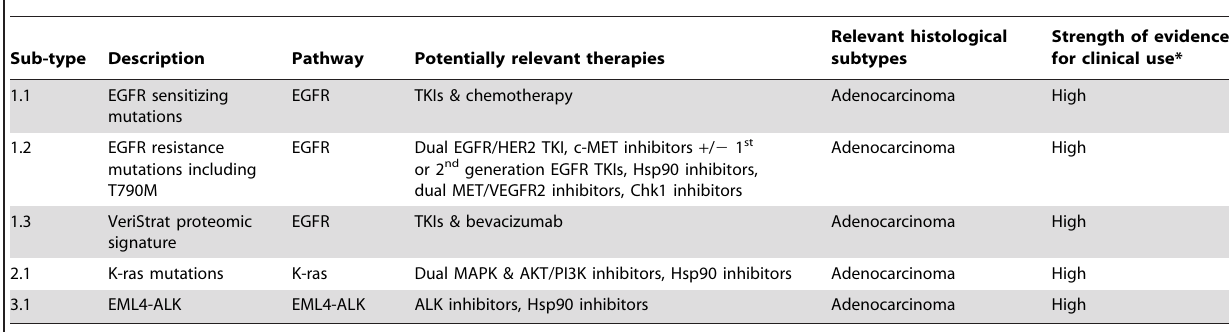
Table 1. Principle lung cancer molecular subtypes.